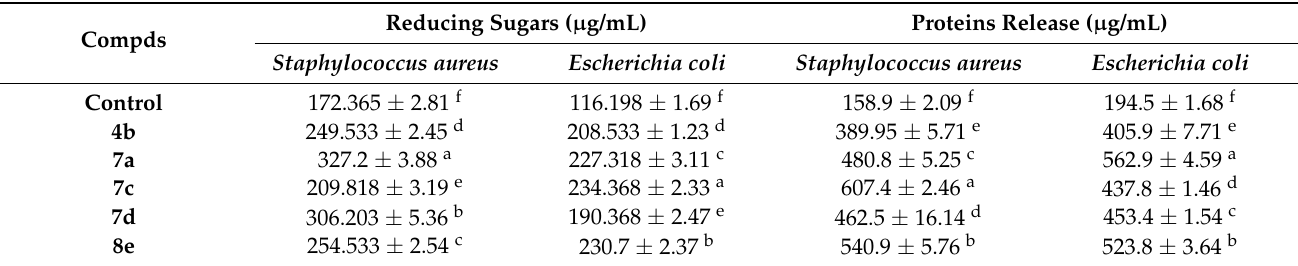
Table 4. Reducing sugars and proteins released from Staphylococcus aureus and Escherichia coli cultures treated with the most active selected compounds compared to untreated cultures (control).